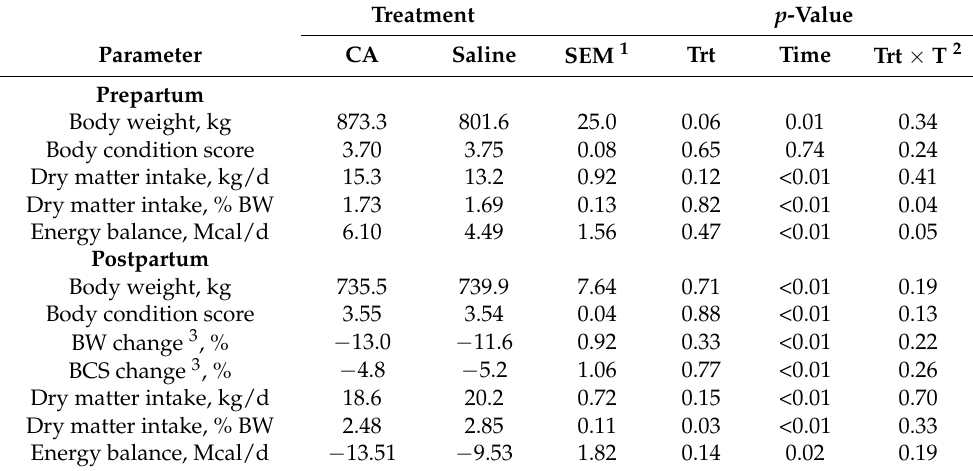
Table 3. Differences between treatments groups during prepartum and main residual effects of intravenous infusion of carnosic acid (CA) or saline solution (Saline) on BW, BCS, DMI, DMI as % of BW, and energy balance.